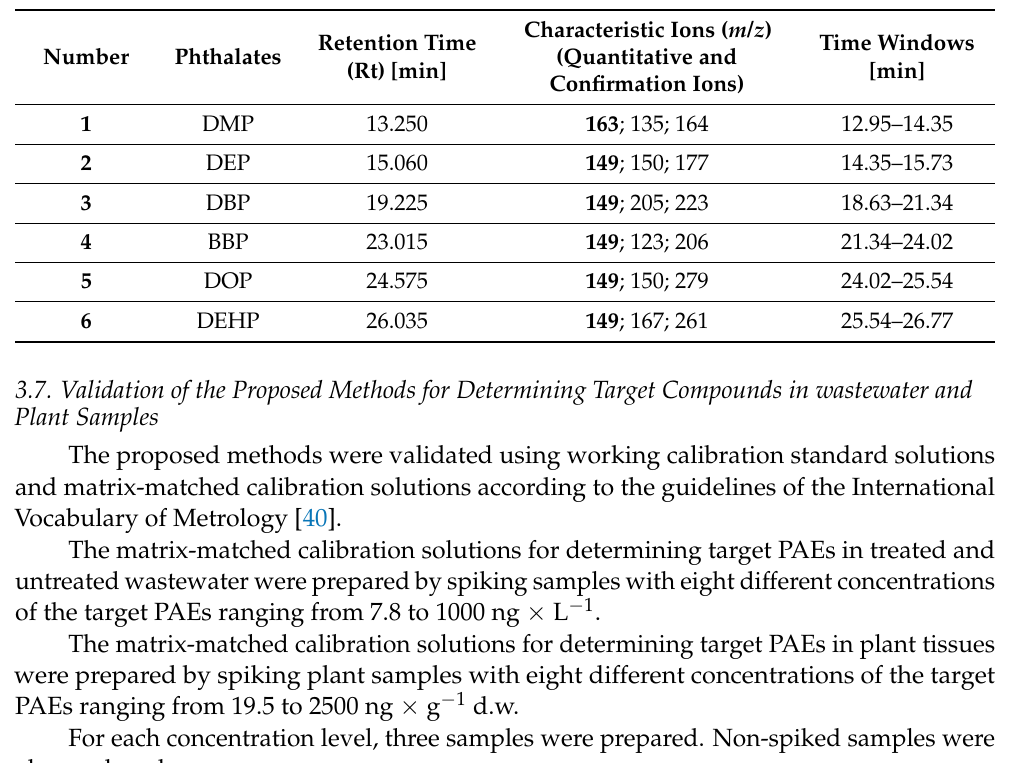
Table 7. Retention parameters (time allowed change ± 0.15 min), time windows and SIM ions for the target compounds (quantitative and confirmation ions; quantitative ions are marked in